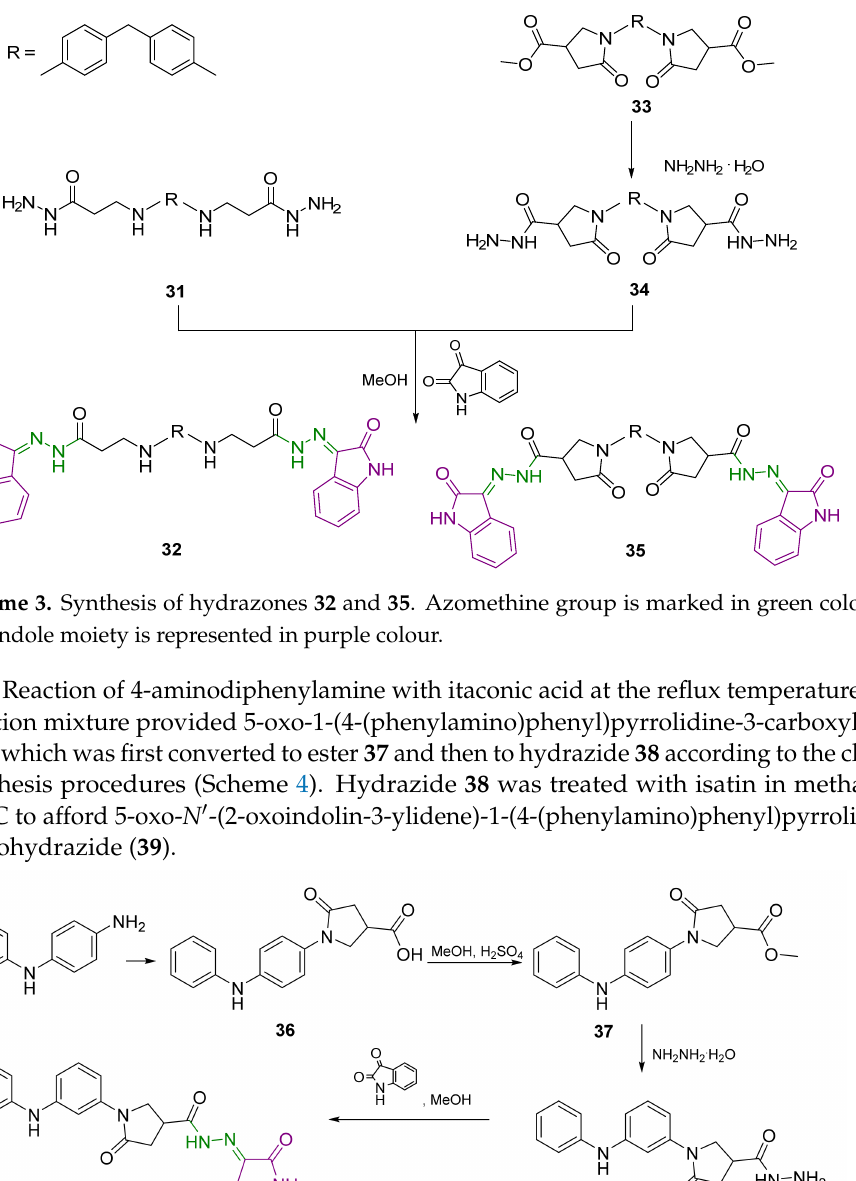
Scheme 4. Synthesis of hydrazone 39 . Azomethine group is marked in green colour and 2-oxin- dole moiety is represented in purple colour.